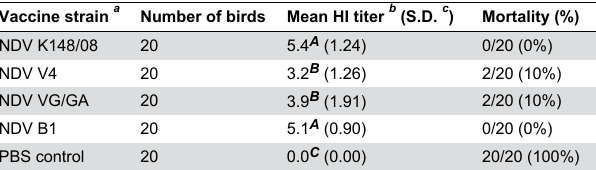
Vaccine strain a Number of birds Mean HI titer b (S.D. c )